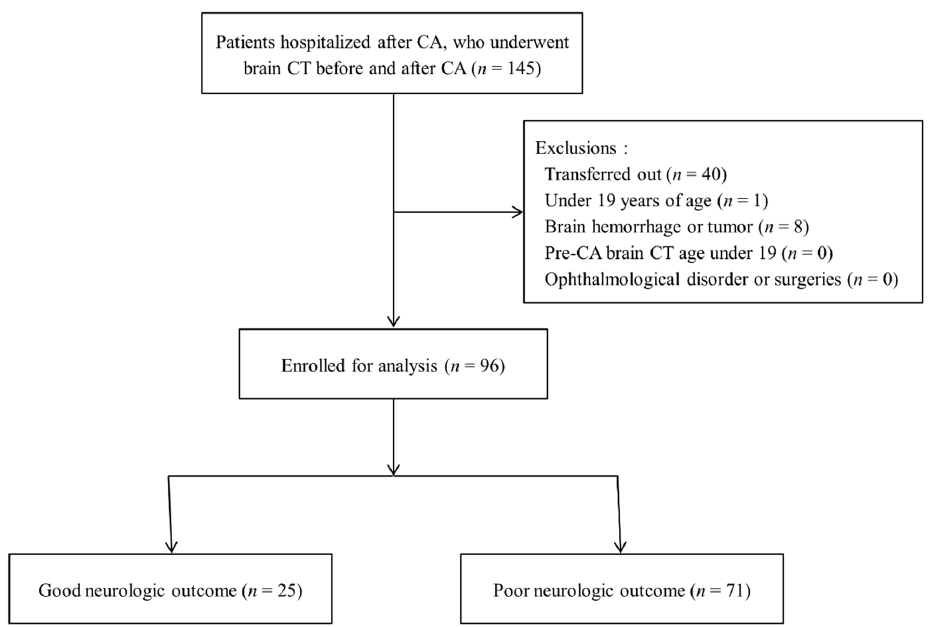
Figure 1. Flow chart of the study process. Table 1. Baseline characteristics of enrolled patients.